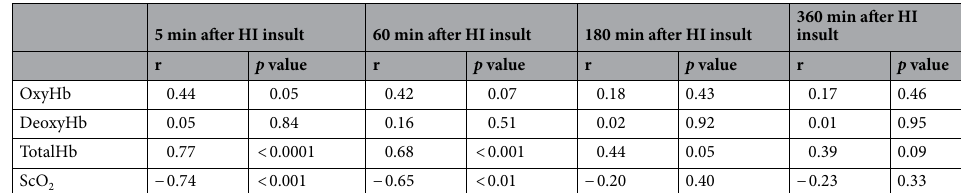
Table 3. Correlation between changes in oxyHb, deoxyHb, total Hb and ScO2 during HI insult and at 5, 60, 180, and 360 min after insult. deoxyHb the concentration of deoxyhemoglobin, HI hypoxic–ischemic, oxyHb the concentration of oxyhemoglobin, ScO 2 cerebral Hb oxygen saturation, totalHb the concentration of total